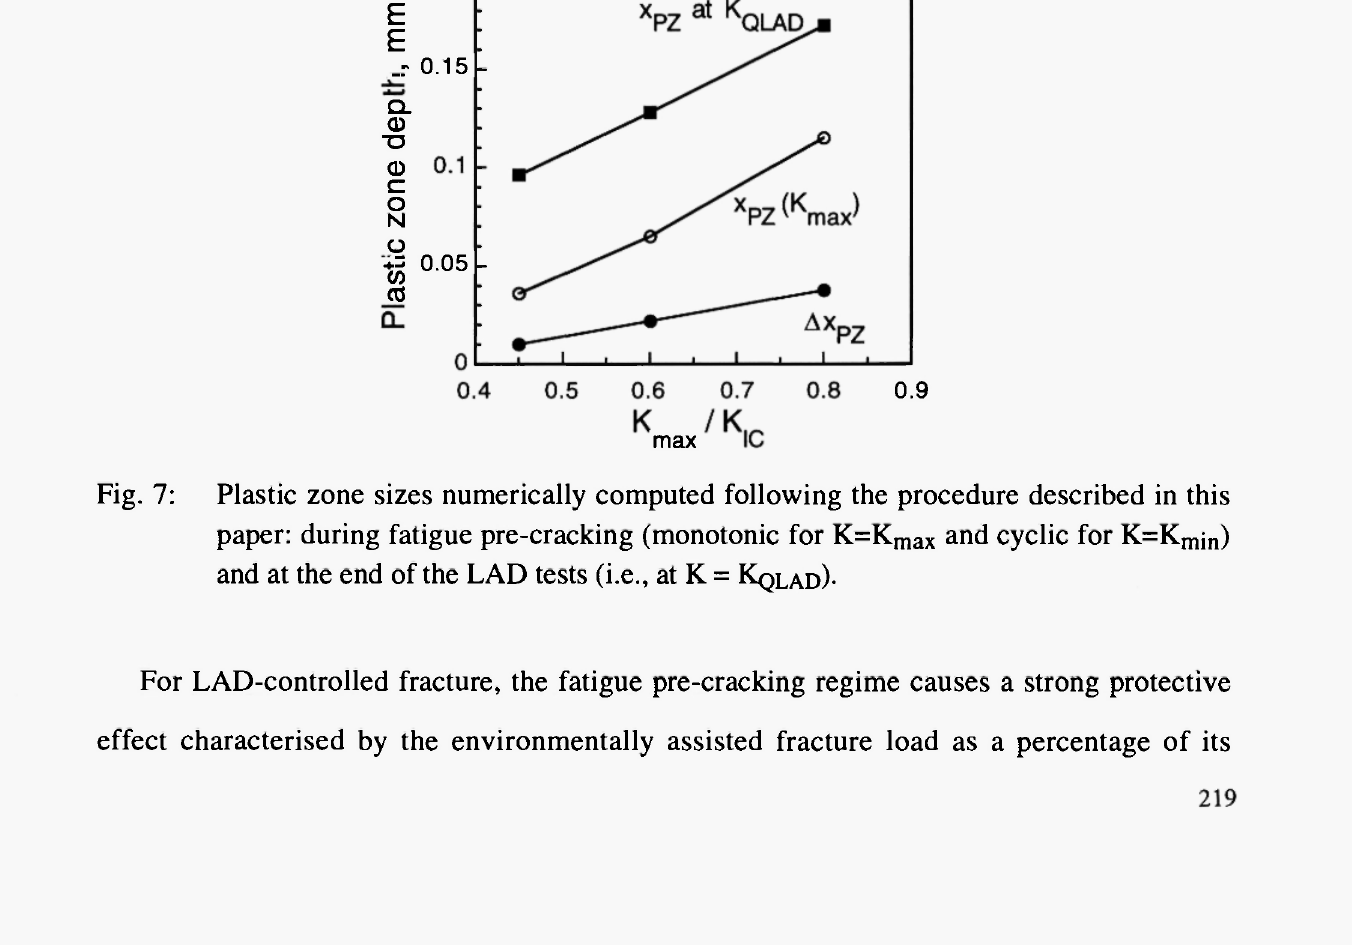
Fig. 6: Plastic zone sizes theoretically predicted according to the model proposed by Rice /8/: during fatigue pre-cracking (monotonic for K=K the end of the LAD tests (i.e., at Κ = K q l a d )·